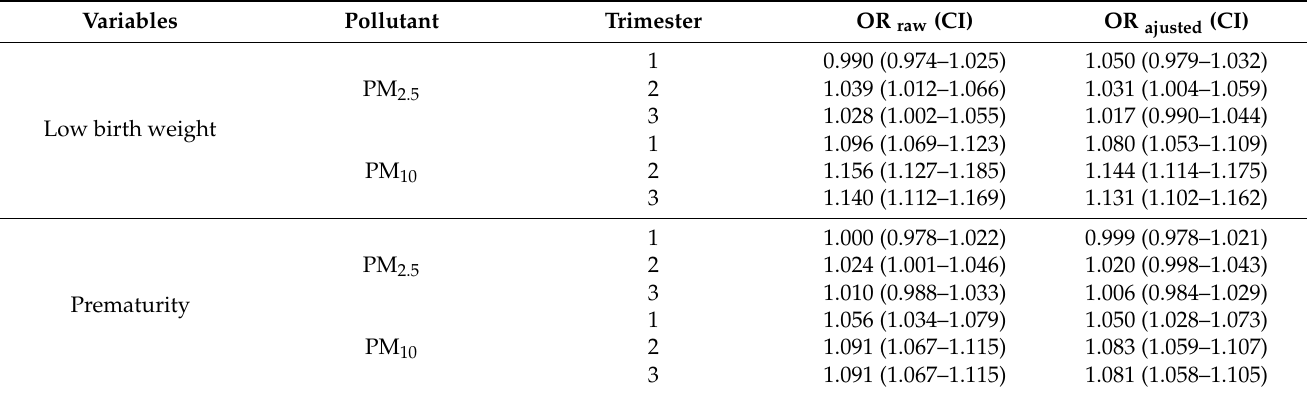
Table 2. Multiple logistic regression model for the association of prematurity and low birth weight with air